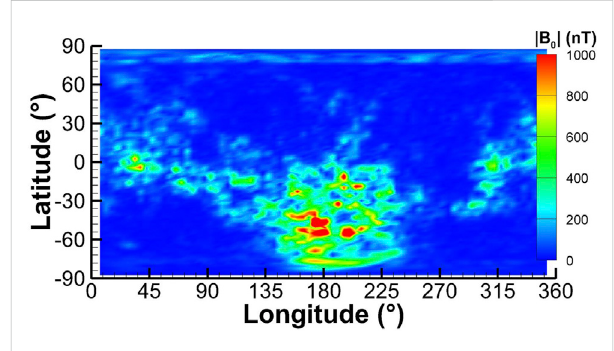
FIGURE 1 Distributionsofthecrustal fi eldstrengthatthealtitudeof100 km calculated by the 110 ° spherical harmonic model developed by Gao et al.